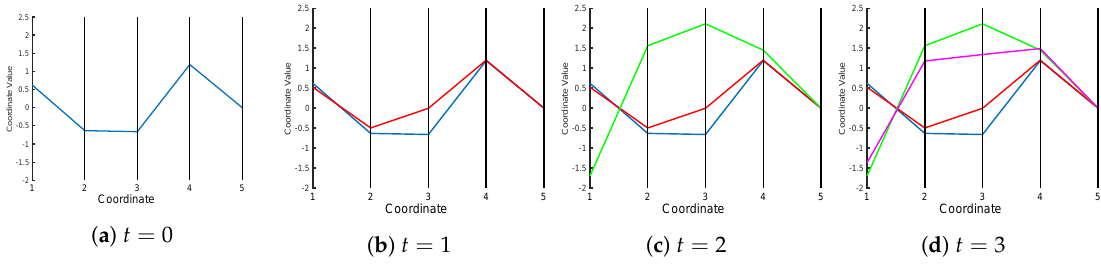
Figure 1. Data visualization in parallel coordinates for a five-dimensional dataset. Each coordinate can be regarded as the ordinate of a regular time series plot. Data samples are added to the plot as they are acquired, in the form of a set of linear segments. As time progresses ( a – d ), current data are typically shown along with previously-plotted information to capture